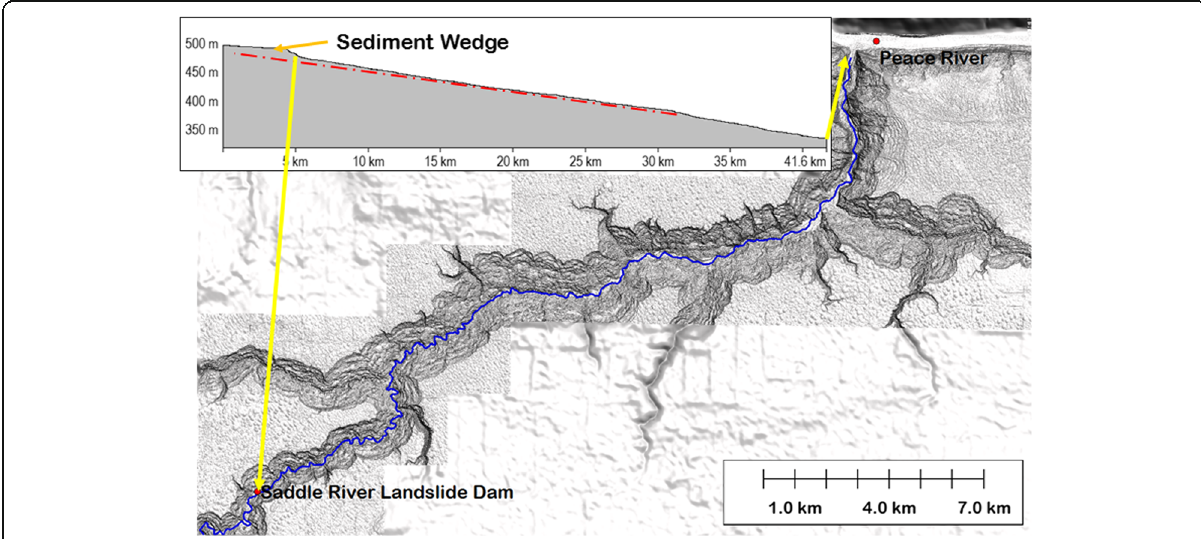
Fig. 14 Plan view and channel longitudinal profile of the Saddle River, generated from 2 m lidar data (dated October 22, 2013; source: Government of Alberta, reproduced with permission). The longitudinal profile extends from near the Peace River to approximately 4 km upstream of the landslide dam. The red line roughly follows the longitudinal profile of the lower Saddle River (below the landslide). The grey area situated above red line indicates areas of sedimentation upstream of the landslide